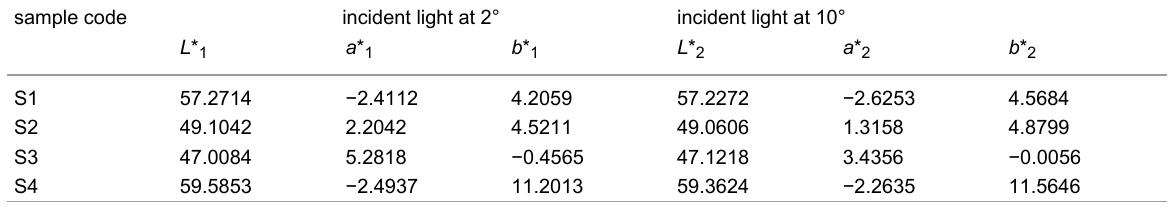
Table 2: L *, a *, and b * values under different incident light angles. a